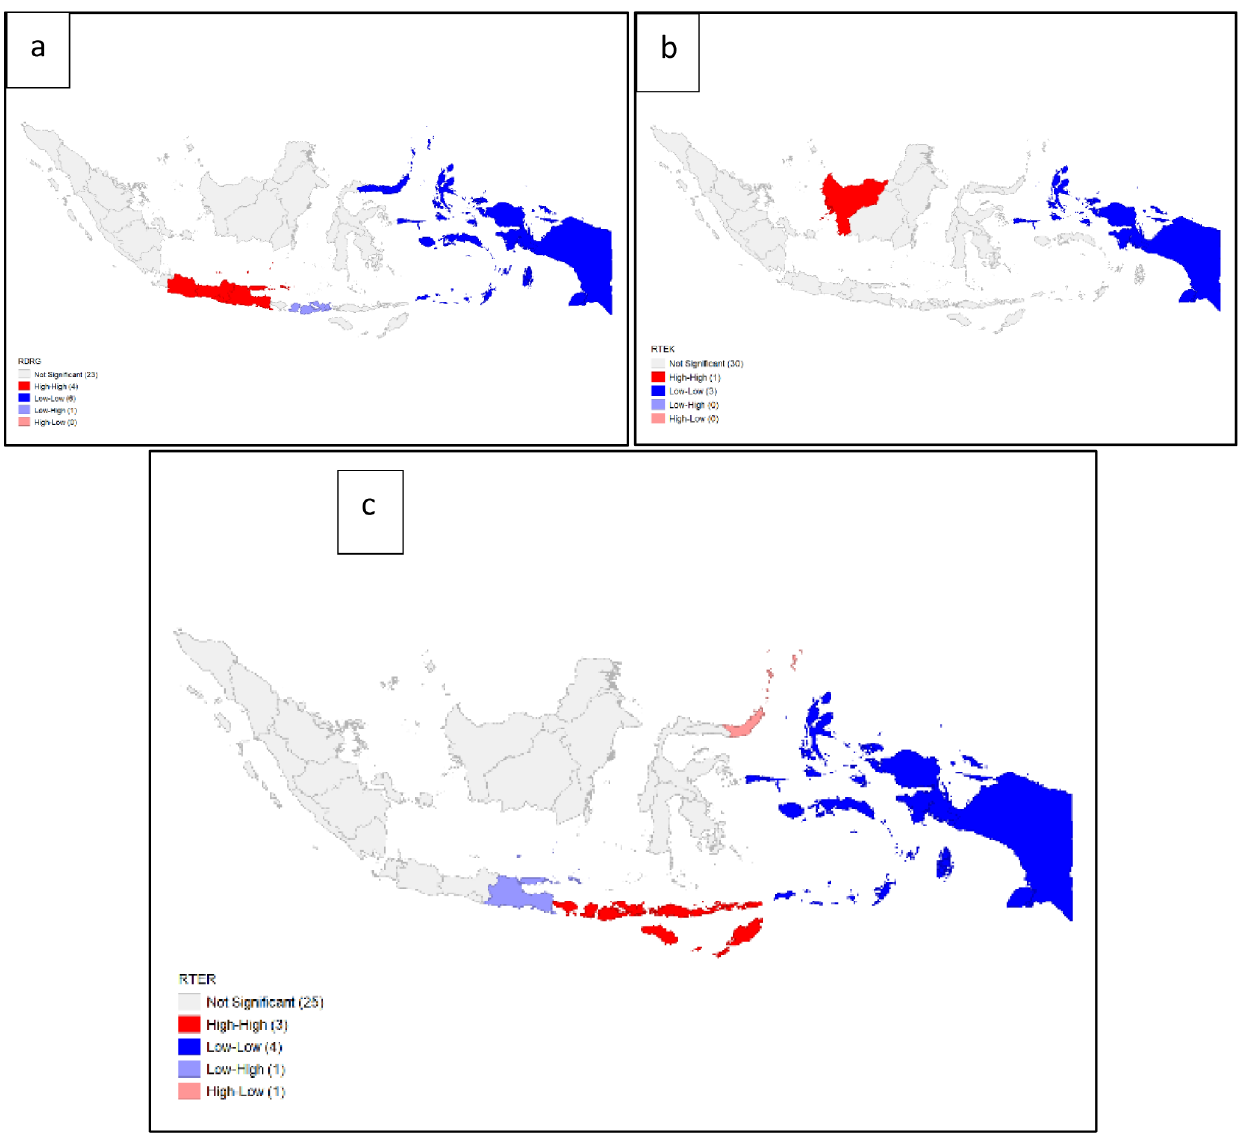
Figure 8. Autocorrelation local indicator of spatial autocorrelation (LISA) map of dentists per area ( a ), dental therapists per area ( b ), and dental technicians per area ( c ). Grey = not significant, red = high-high,blue = low-low, purple = low-high, peach =